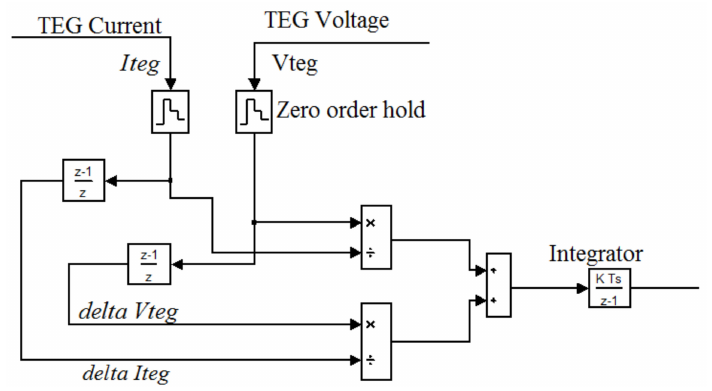
Figure 6. MATLAB model incremental resistance (INR)